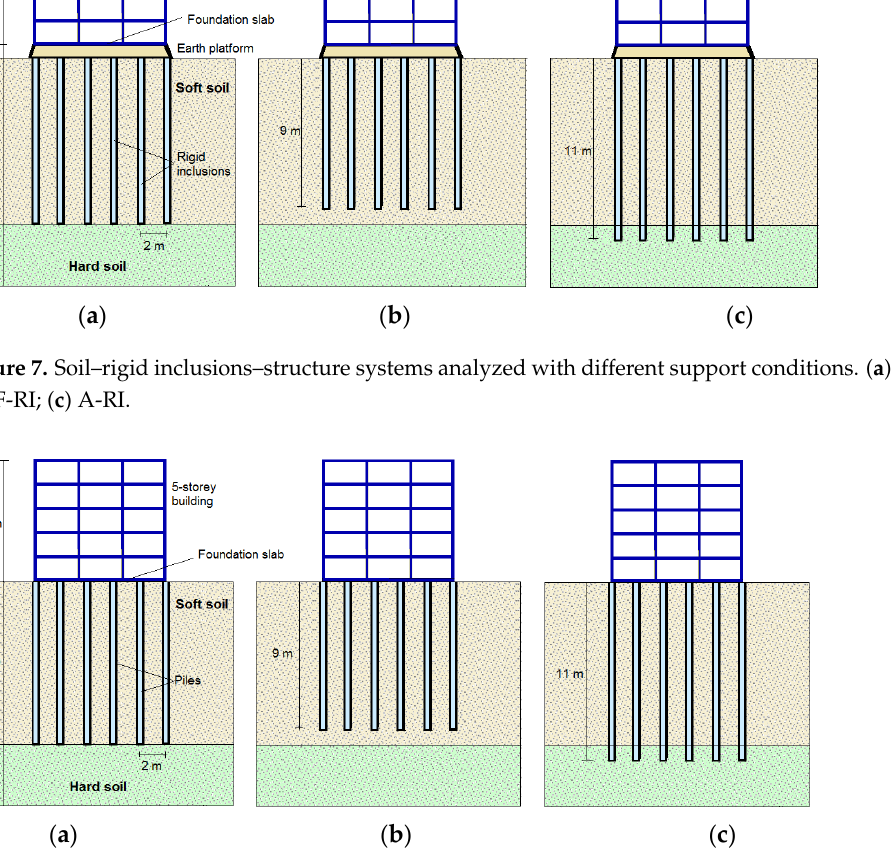
Figure 8. Soil–piles–structure systems analyzed with different support conditions. ( a ) P–P; ( b )